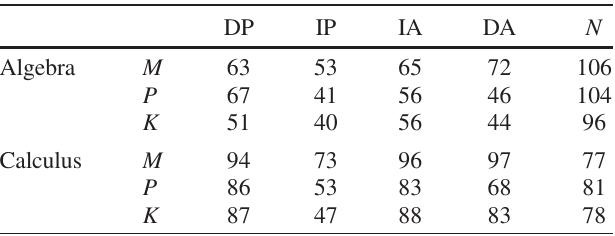
TABLE II. Percentage of correct answers per context and function type. The last column shows N , the number of student answers per item type.